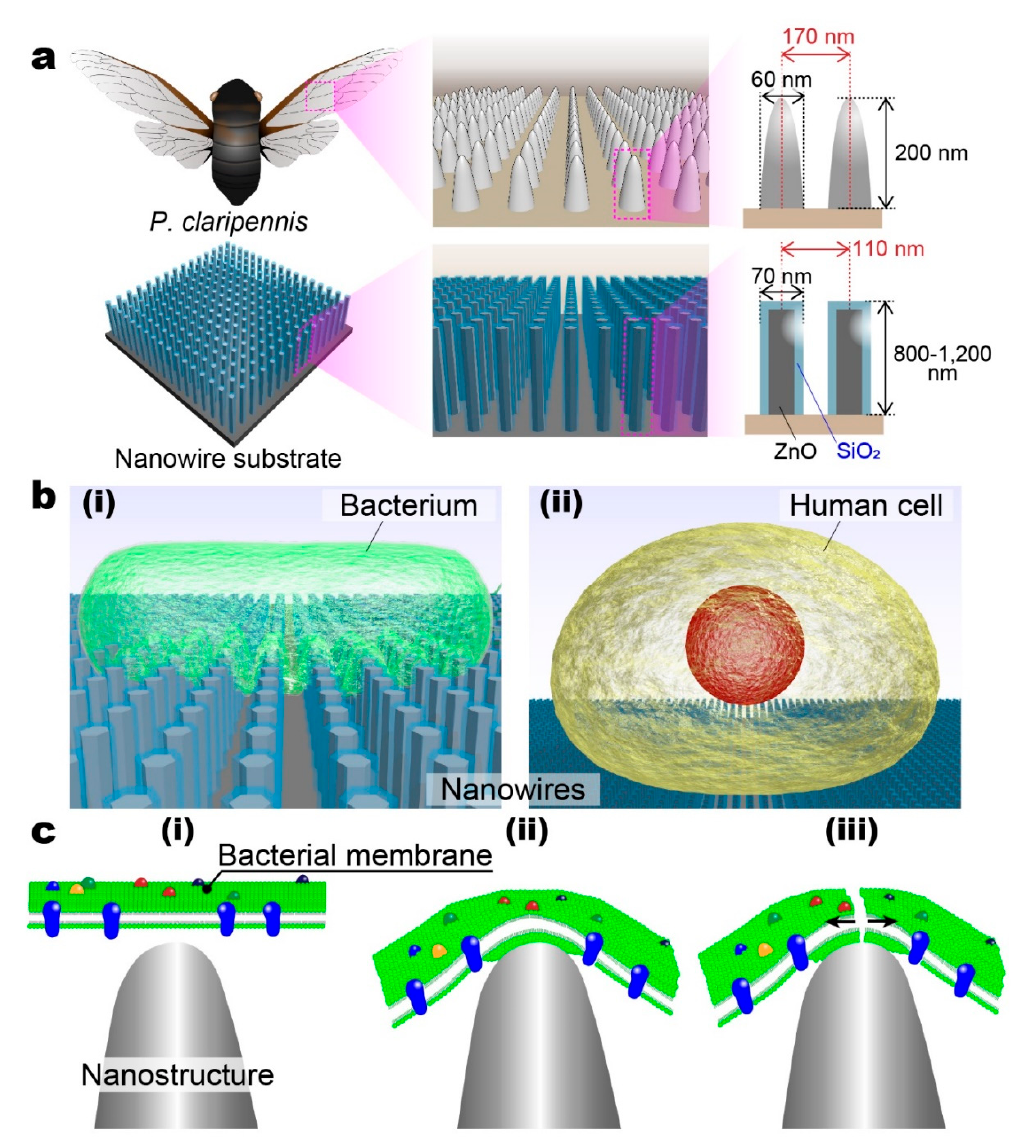
Figure 1. ( a ) Schematic illustrations of nanostructures on the wing of P. claripennis (upper) and antibacterial nanowire substrate (lower). Although arraigned nanowire structures are simply illustrated here, fabricated nanowires were randomly orientated. ( b ) Schematic illustrations of (i) a bacterium and (ii) human cell on nanowire structures. While the human cell attached on the nanowire structures was alive, the bacterium on the structures was mechanically ruptured and inactivated. ( c ) Schematic illustrations of the bacterium rupture mechanism. (i) A cell membrane of the bacterium was attached on the nanostructure. (ii) The membrane was stretched via the nanostructure and the surface area of the membrane increased. (iii) The membrane was ruptured due to too much